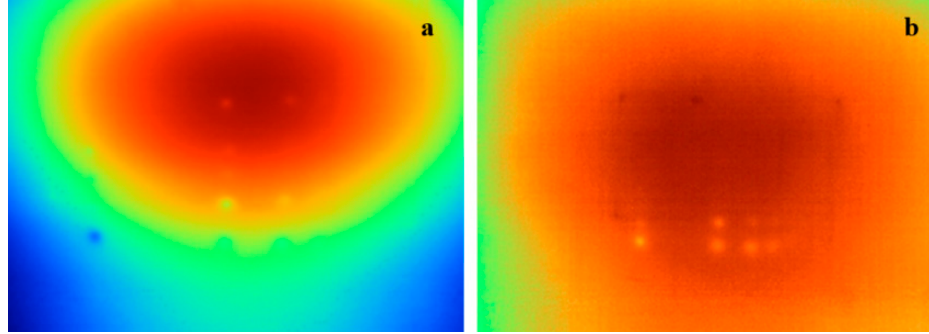
Figure 14. Impact of close heating on the defect detection ( a ) localized and non-uniform heating ( b ) uniform heating.